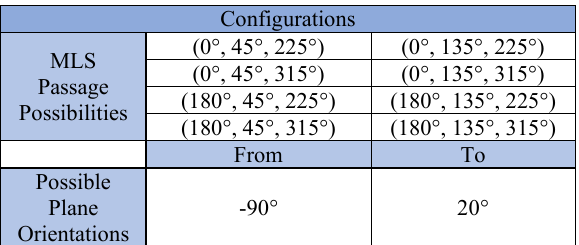
Table 1 – Possible configurations for pitch boresight angle systematic error